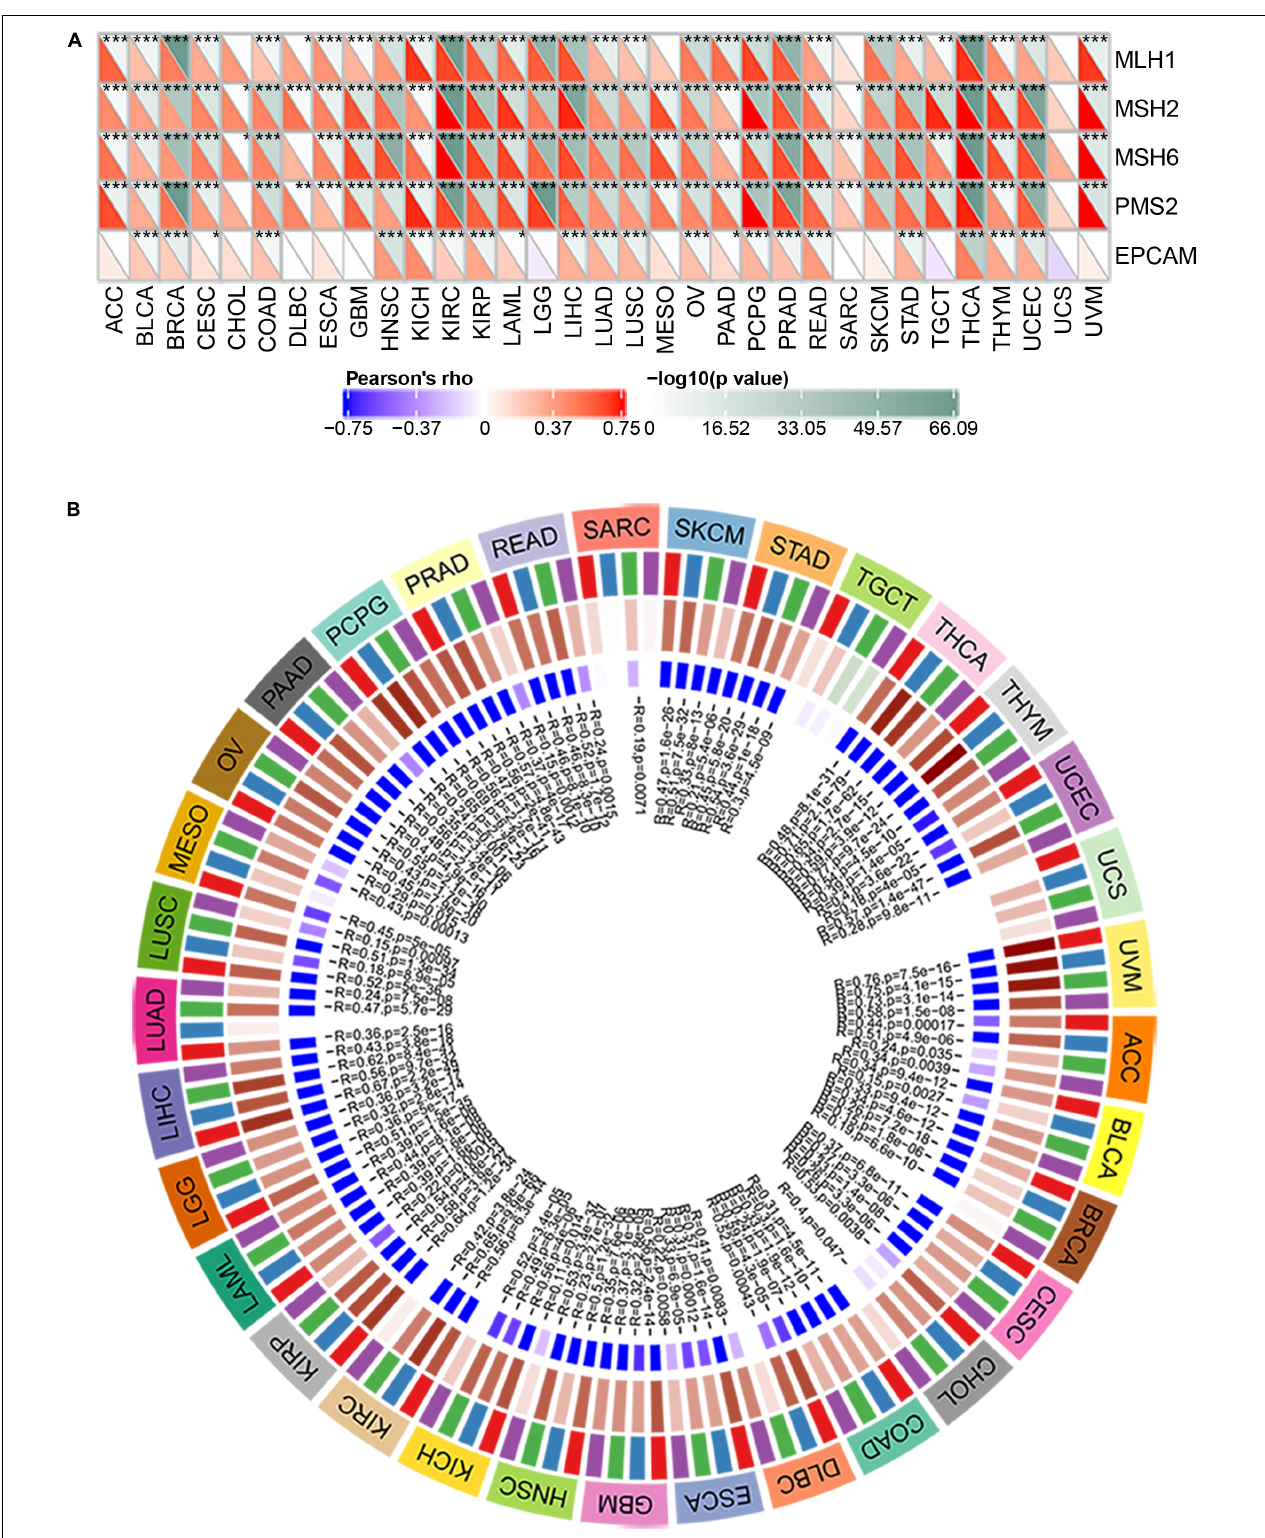
FIGURE 2 | BRAP is correlated with MMR gene mutation levels and DNA methyltransferases expression in human pan-cancer. (A) Pearson correlation analysis of BRAP expression with mutation levels of MMR genes in human pan-cancer (* P < 0.05, ** P < 0.01, *** P < 0.001). (B) Pearson correlation analysis of BRAP expression with DNA methyltransferases in human